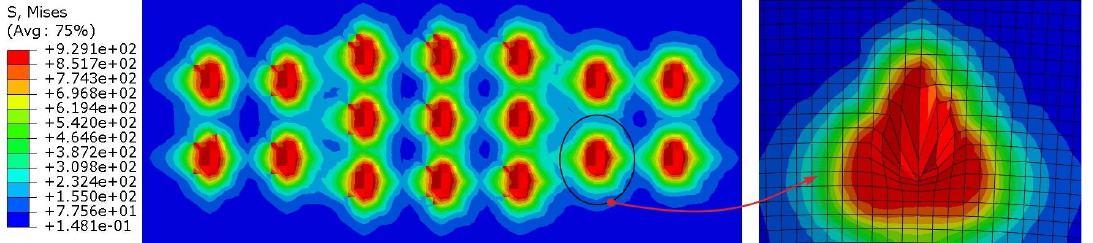
Figure 13. The stress distribution of casing wall (before optimization).